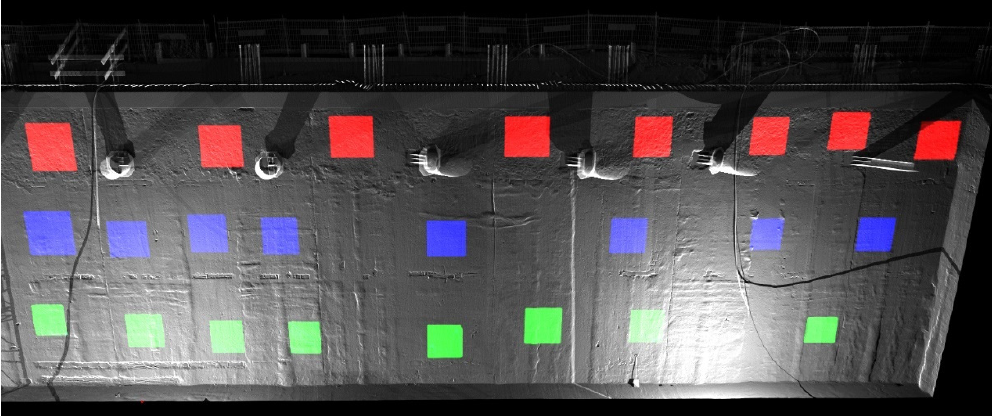
Figure 8. Location of measurement samples on the diaphragm wall in individual geotechnical layers: red color samples from Mg (anthropogenic soil), blue color samples from MSa (medium sand), green color samples from grSa (sandy gravel).